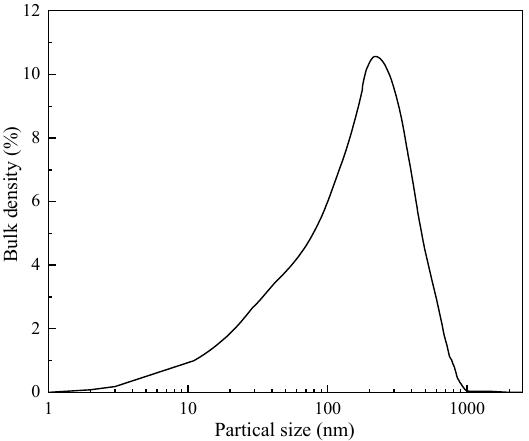
Figure 6. Particle size distribution of modified ZIF after aging.